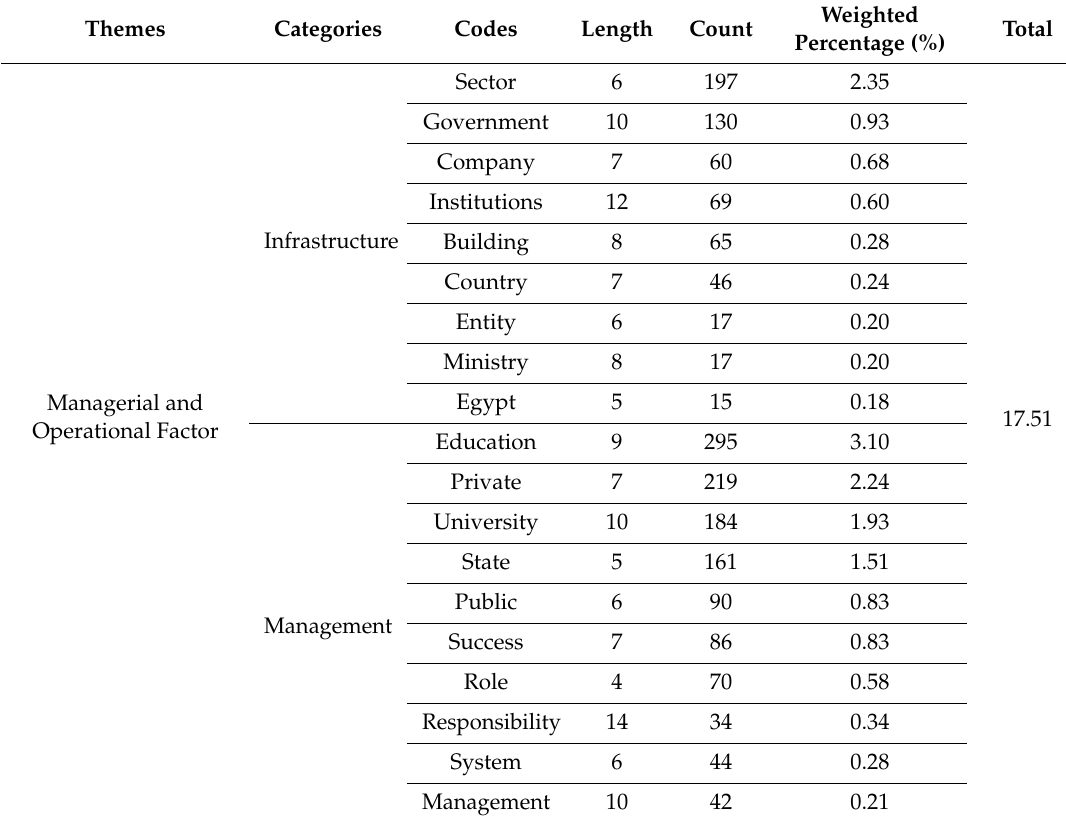
Table 4. Word frequencies for managerial and operational factor theme.